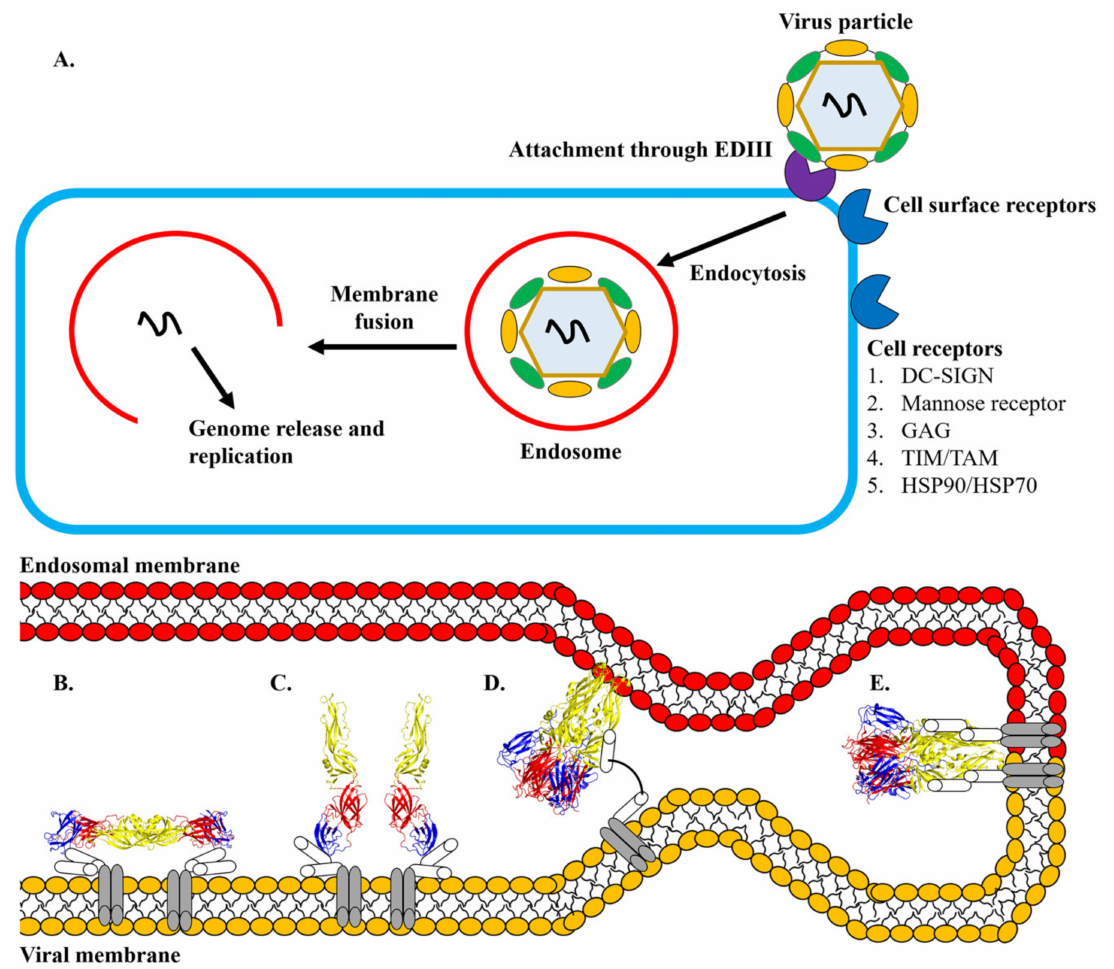
Figure 3. DENV attachment and fusion (PDB IDs: 1OAM and 4GSX). ( A ) Endocytic entry pathway of DENV. B-E) Proposed mechanism for DENV-host cell membrane fusion. The stem region of E protein is in white while the transmembrane anchor is in grey. The EDI, EDII and EDIII are in red, yellow and blue, respectively. ( B ) The binding of E protein to the receptor leads to the internalization of the DENV into an endosome. Reduced pH in the endosome causes the rearrangement of the E protein from dimer to trimer. ( C ) During the rearrangement, the tip of the EDII hinges outwards from the virion surface, allowing the fusion loop to be inserted into the cellular membrane to bridge cellular and viral membranes. ( D ) The bending and hemifusion of the membranes are mediated by the contacts made between EDIII-EDI and EDII-stem region. ( E ) Finally, the fusion loop makes contact with the transmembrane domain, completing membrane fusion and formation of pores. Figure 3A was modified from Hidari et. al. (2013) and Figure 3B-E was modified from Klein et. al. (2013)